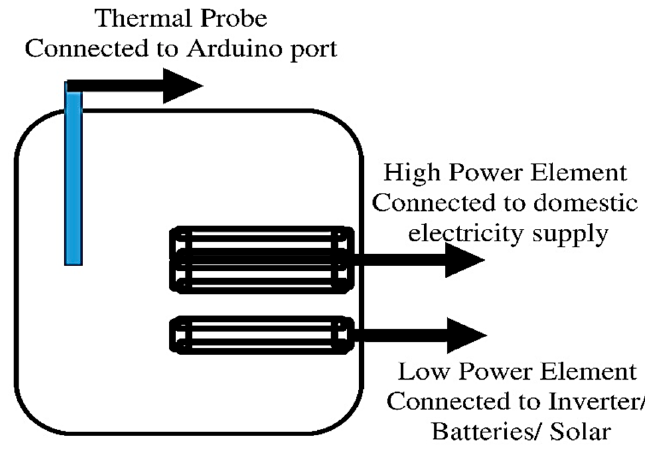
Figure 5. Two-element water heating system.